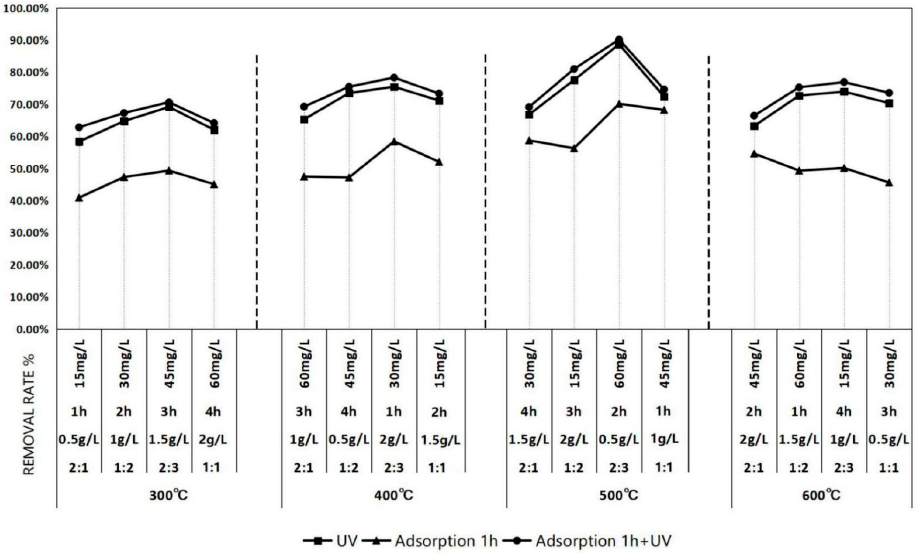
Figure 11. The orthogonal test results via five factors and four levels.